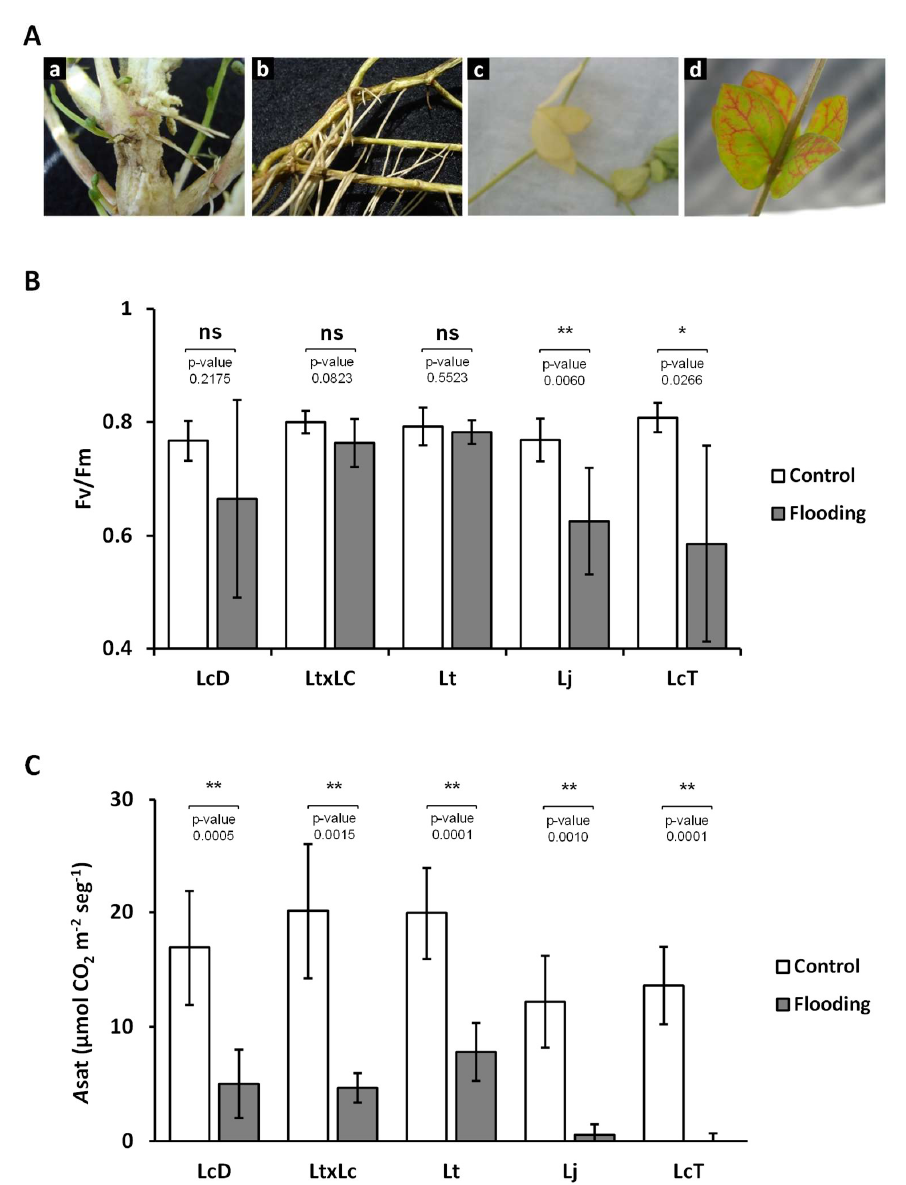
Figure 1. Effects of partial submergence in different species of the Lotus genus. ( A ) Representative photographs of L. corniculatus diploid (LcD) plants after 42 days of treatments (control and flooding). Plants were grown under partial submergence described in Material and Methods and details of different symptoms are shown: (a) Thickening; (b) adventitious roots; (c) chlorosis; and (d) reddish veins. ( B ) The maximum quantum yield of primary Photosystem II (PSII) photochemistry ( F v / F m). ( C ) Net photosynthetic rate under saturating irradiance ( Asat ). Values are means ± SD of six biological replicates. Between treatments for each genotypes, one asterisk ( P < 0.05) and two asterisks ( P < 0.01) over the bars mark a significant difference; ns indicate no significant difference ( P > 0.05). LcD: L. corniculatus diploid, Lt: Lotus tenuis , LtxLc: L. tenuis × L. corniculatus , Lj: L. japonicus and LcT: L. corniculatus tetraploid plants.